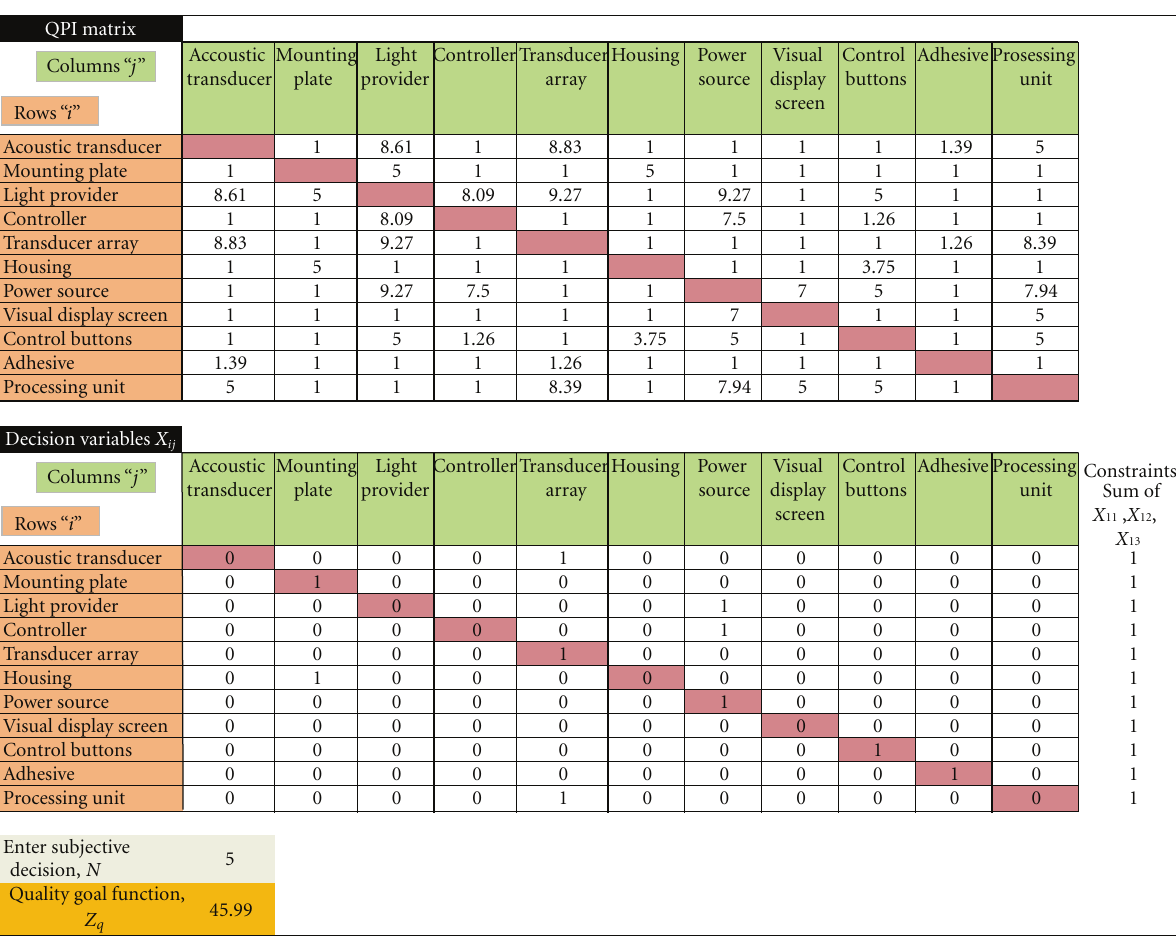
Figure 6: Quality goal function—stakeholder 1